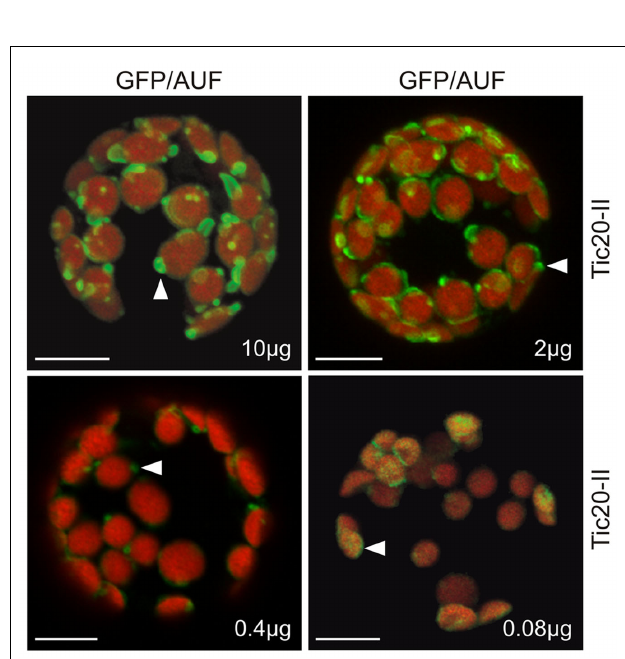
FIGURE 4 |The alteration of membrane morphology is concentration dependent. Various concentrations (10, 2, 0.4, and 0.08 μ g) of at Tic20-II–GFP plasmid DNA adjusted to a total of 10 μ g DNA with empty vector were used to transfect A. thaliana mesophyll protoplasts. Arrowheads point to examples of changes in membrane